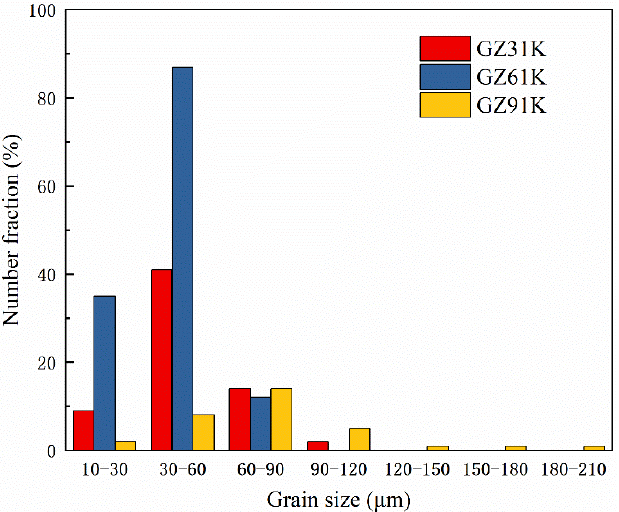
Figure 2. The α -Mg grain size distribution of the T6-treated alloys.